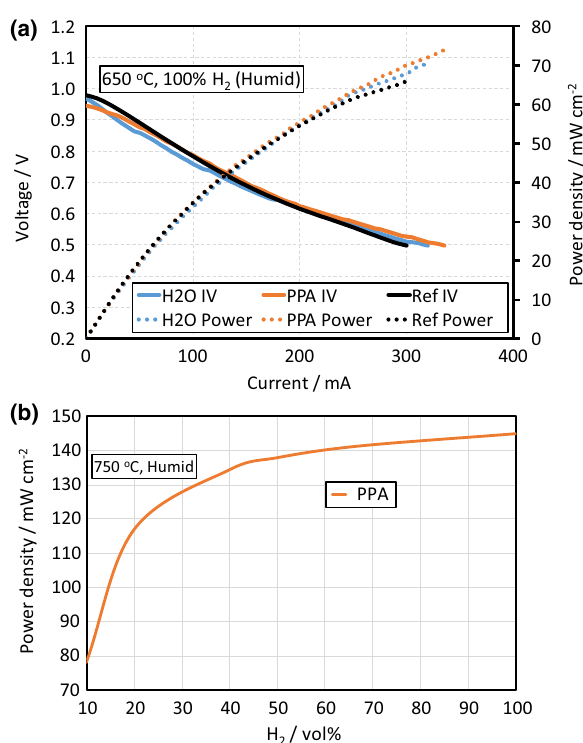
Fig. 6 a I-V characteristics and resulting power curve for both infiltrated and reference fuel cells. The infiltrated cells only show a small improvement in the maximum power output relative to the reference cell at impractically low voltages. b The power density shows a sharp decrease when the fuel concentration is reduced indicating high concentration losses due to low open porosity in the